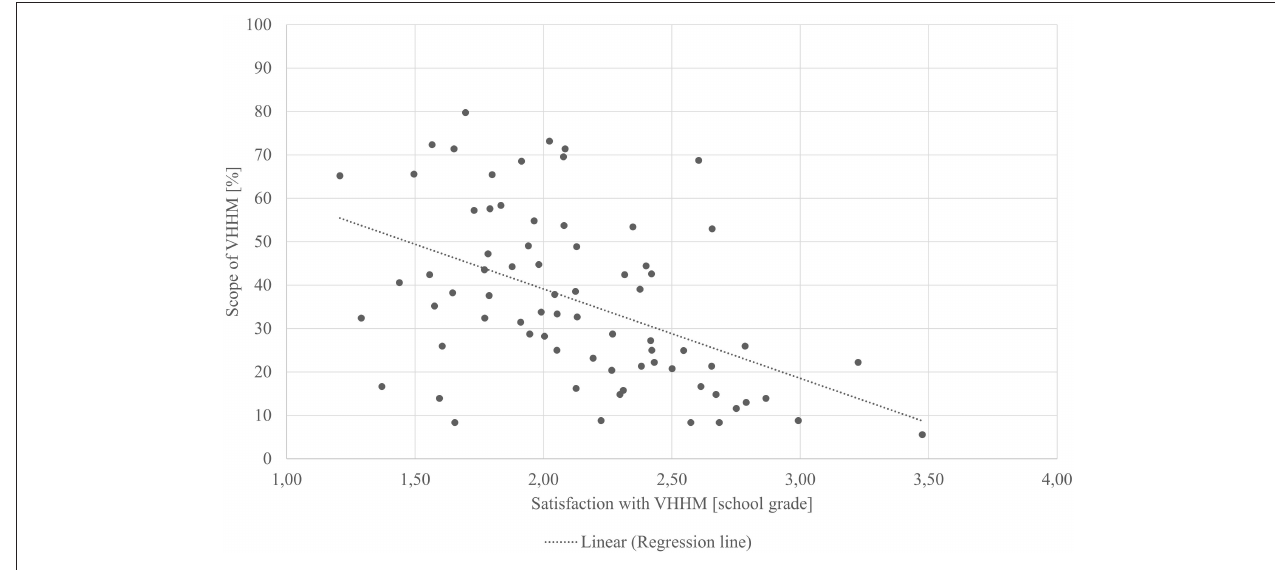
FIGURE 1 | Scatterplot: Scope/satisfaction with VHHM.